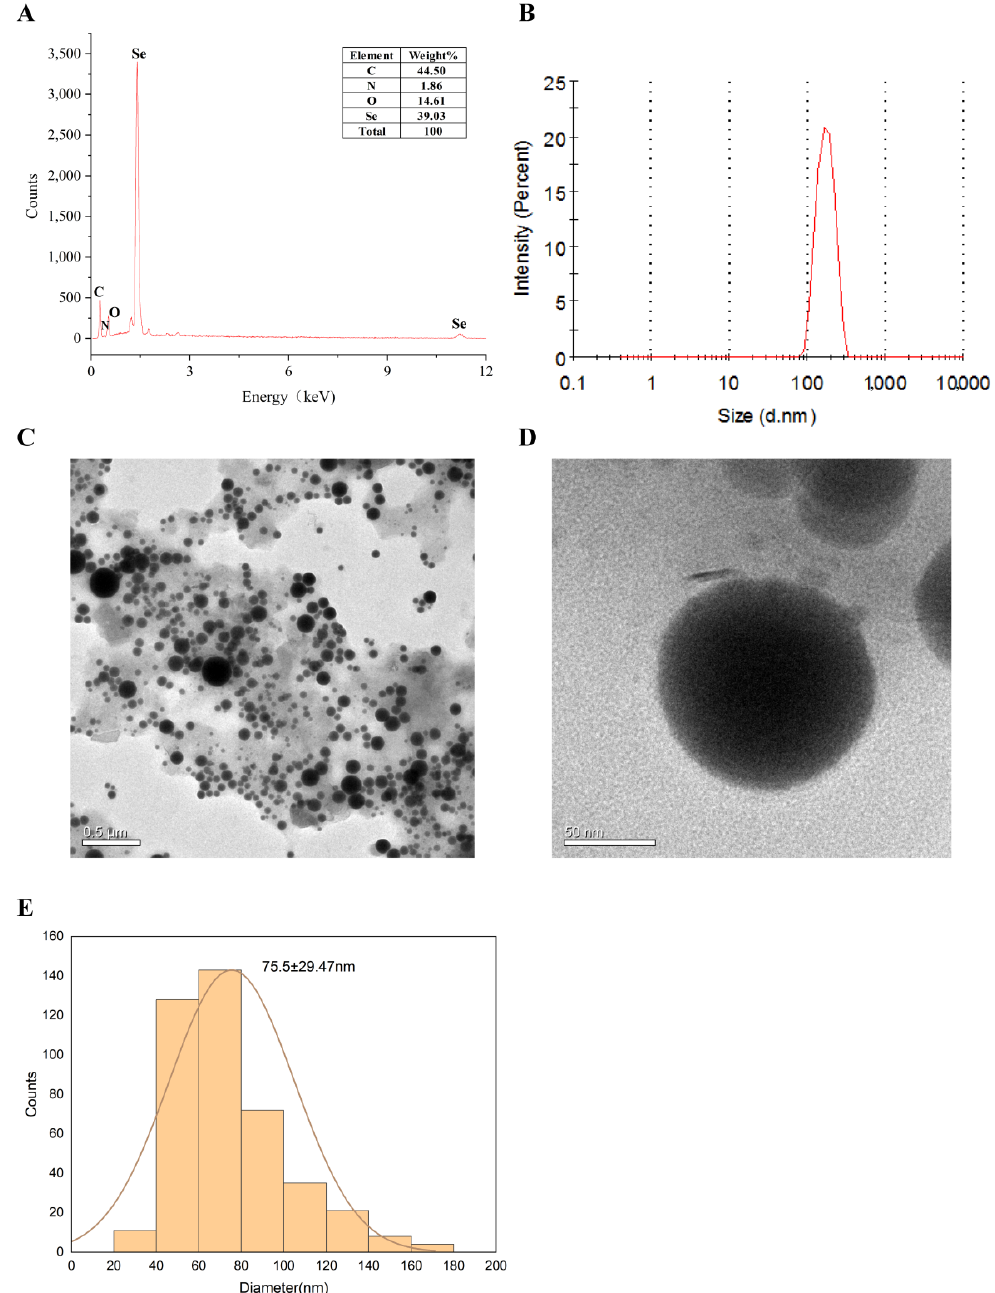
Figure 2. EDX spectrum ( A ); Particle size distribution diagram ( B ); TEM diagram of LCS ‐ SeNPs ( C , D ); Size distribution of LCS ‐ SeNPs ( E ).